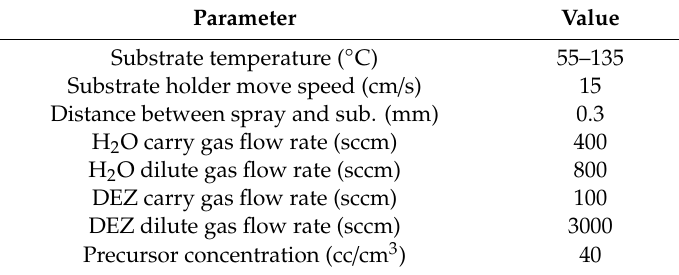
Figure 1. Schematic description of the deposition mechanism of the sALD-ZnO thin film. Table 1. sALD-ZnO deposition parameters.